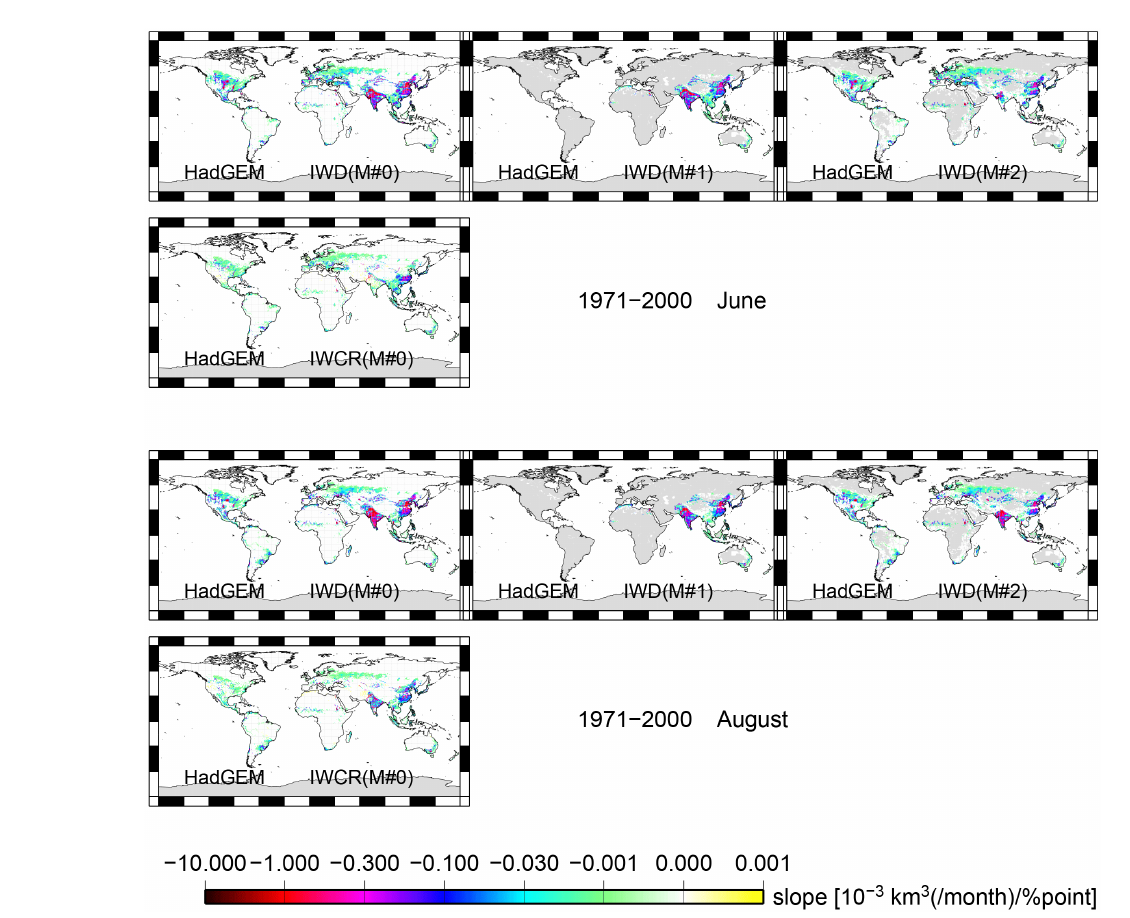
Figure 13. Geographical distribution of sensitivity, given by change in IWD or IWCR per change of 1%RH in the relative humidity. HadGEM results for June and August are shown. Table 6. Global sum of irrigation water demand (IWD) and irrigation water consumption from rivers (IWCR) (km 3 yr − 1 ) with bias-corrected humidity data. See Table 4 for comparison with uncorrected humidity data. The values in parentheses are changes (%) relative to present values. The range (the difference between the maximum and minimum) of the five GCMs is given in the bottom